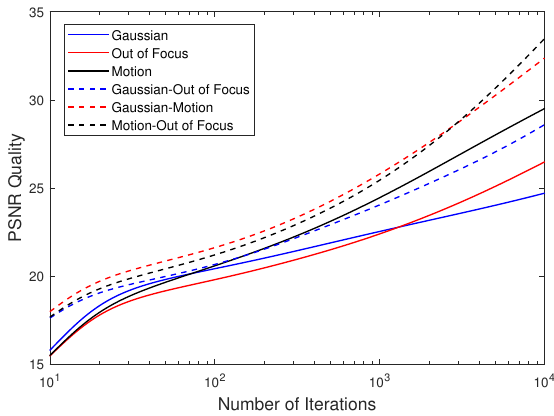
Figure 32. PSNR quality plots of the proposed algorithm in all cases of grey images.